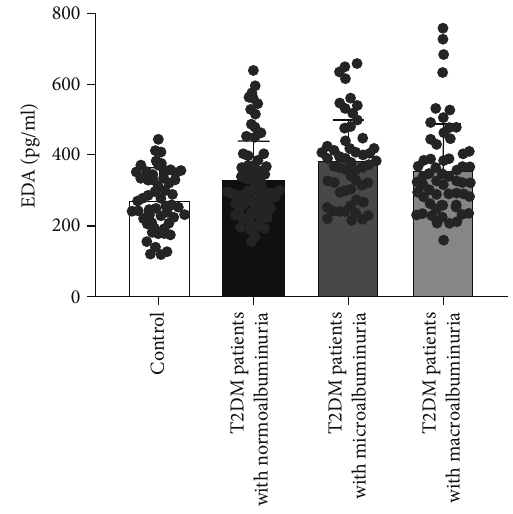
Figure 1: Circulating EDA concentration between di ff erent